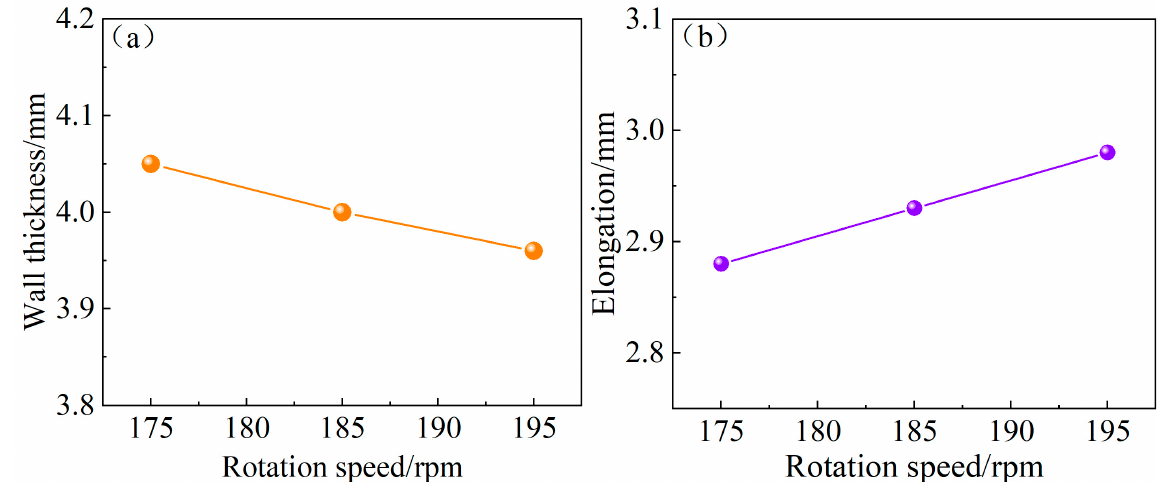
Figure 5. Influence of the roller speed on the tube after the TSR process: ( a ) wall thickness; ( b ) elongation.